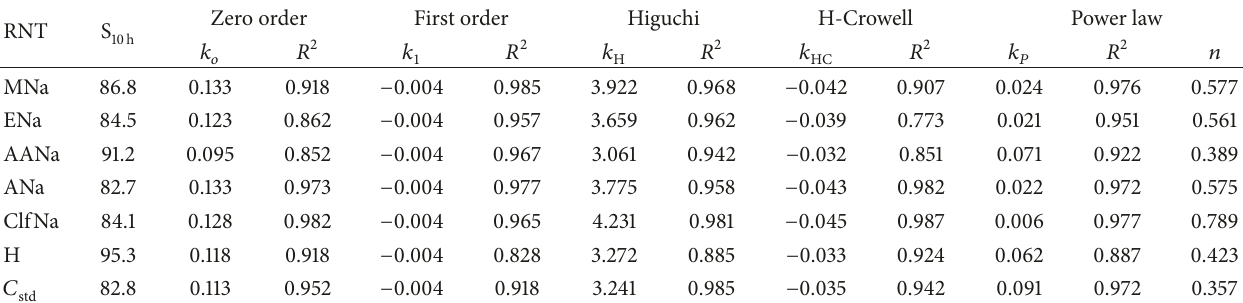
Table 6: Kinetic study of DR from polymer matrix.